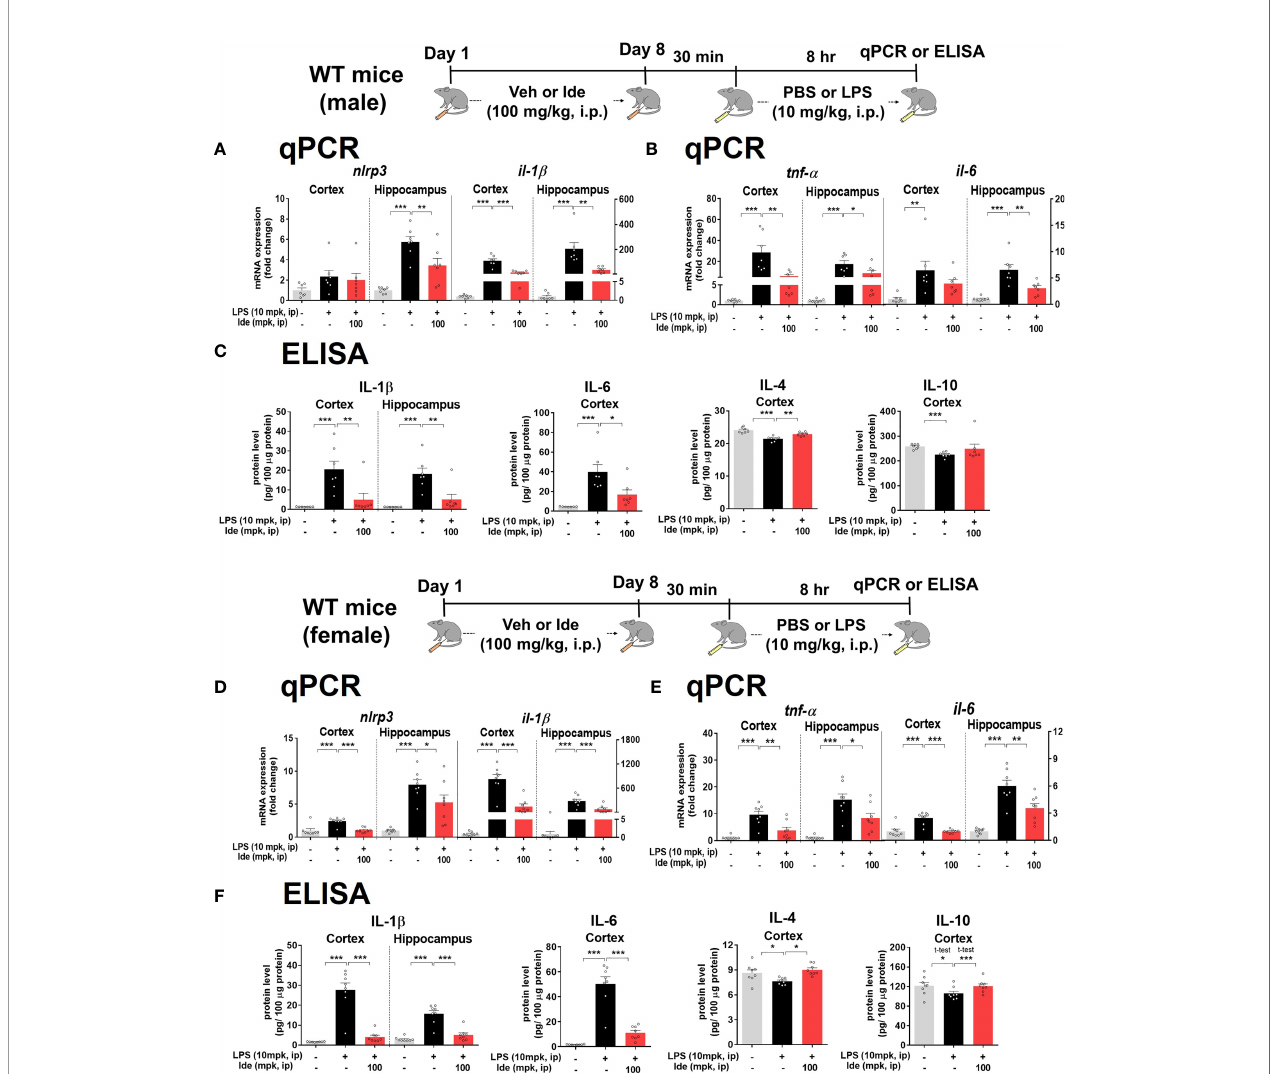
FIGURE 5 | Idebenone ameliorates LPS-evoked NLRP3 in fl ammasome activation and neuroin fl ammation in male and female wild-type mice. (A, D) Relative mRNA levelsof nlrp3 and il-1 b in the cortex and hippocampus. Idebenone (100 mg/kg, i.p.) or vehiclewas administered to maleand femalewild-type mice daily for 8 consecutive days. Thirty minutes after the last injection, LPS (10 mg/kg, i.p.) or PBS was administered,and 8 h later,the cortex and hippocampus were dissected,and real-timePCR was performed (n = 7 – 8 mice/group). (B, E) RelativemRNA levels of tnf- a and il-6 inthe cortex and hippocampus in maleand femaleWTmice (n = 7-8 mice/group). (C, F) ELISA analysisofIL-1 b , IL-6, IL-4, andIL-10 protein levels inmaleand femaleWTmice (n= 7-8 mice/group).*p< 0.05, **p < 0.01, and ***p <